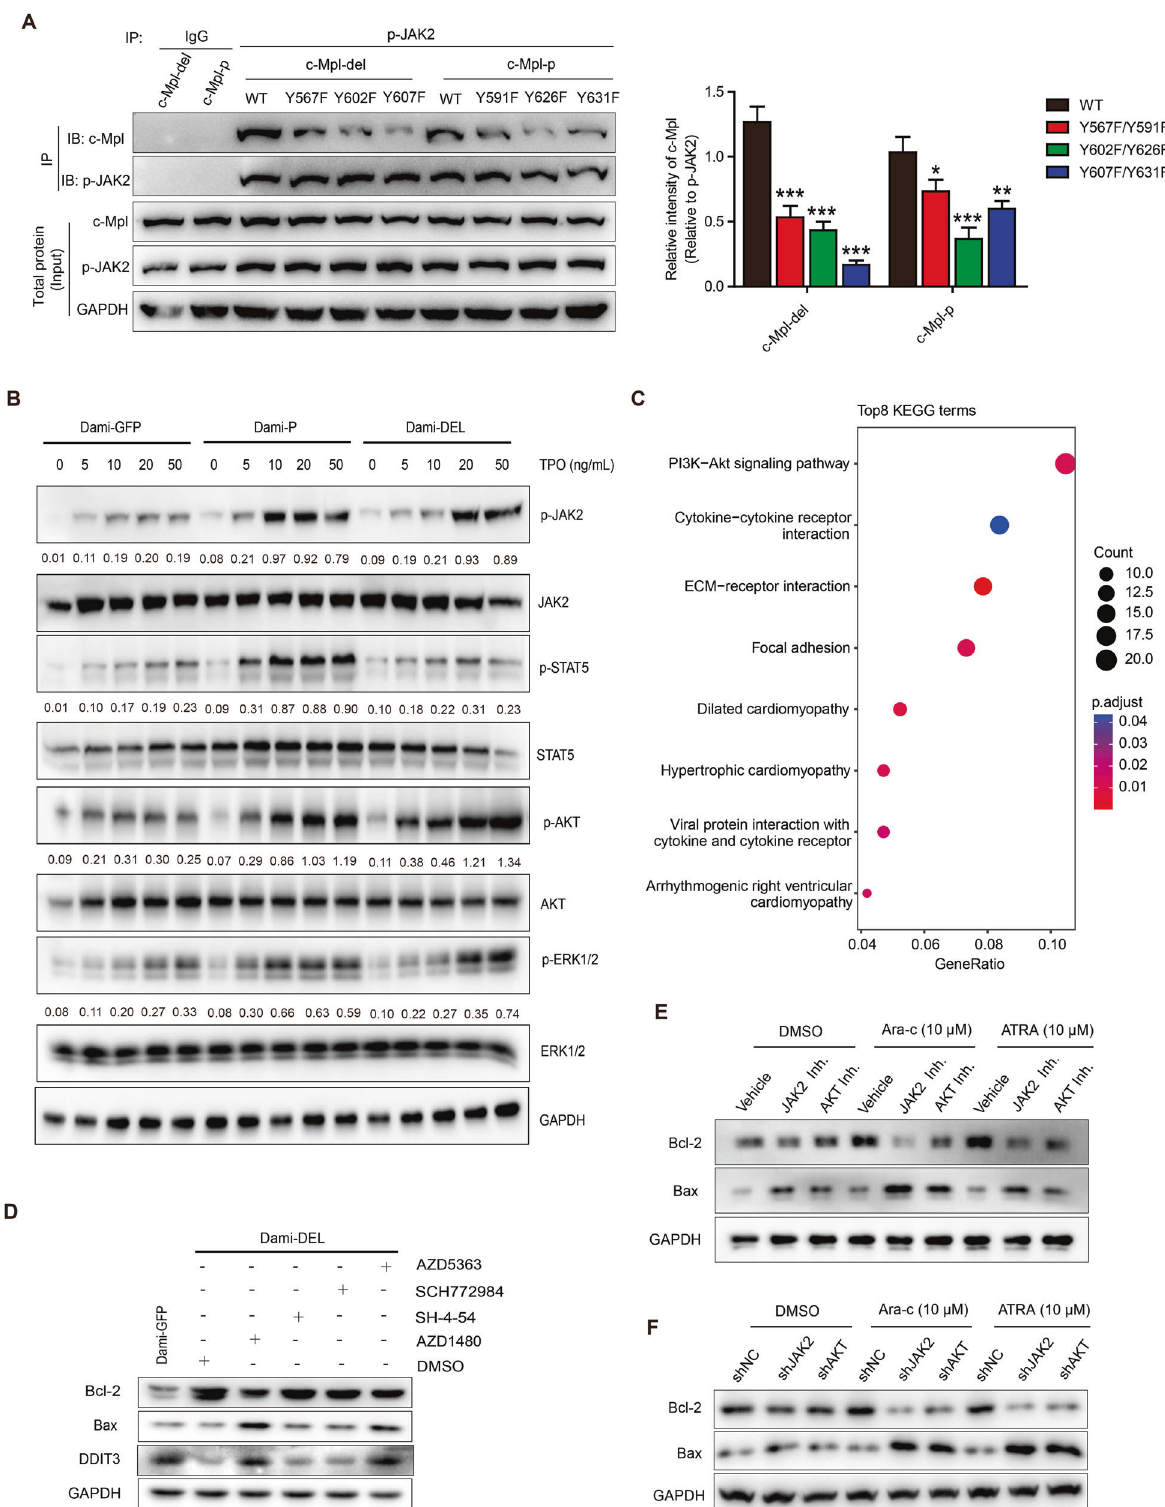
nuclei and less apoptotic as evidenced by increased Bcl-2, decreased Bax and DDIT3 compared to control Dami-GFP/Dami- PM (Fig. 5B, C and Fig. S5A). We further addressed the dynamic in vivo effects of c-Mpl-del on AMKL proliferation and in fi ltration in a metastatic